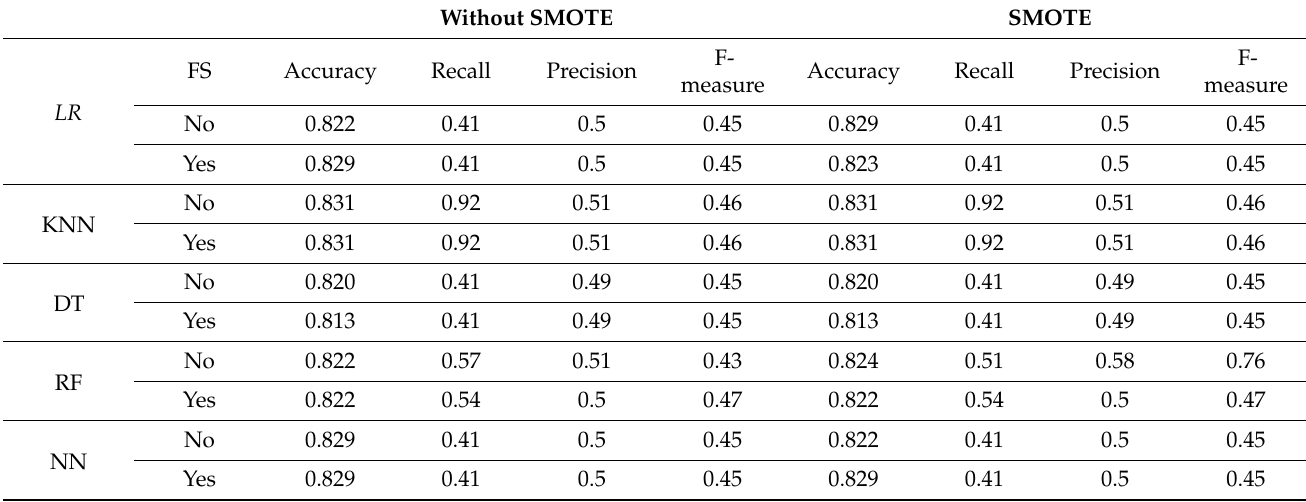
Table 4. Performance of different machine learning